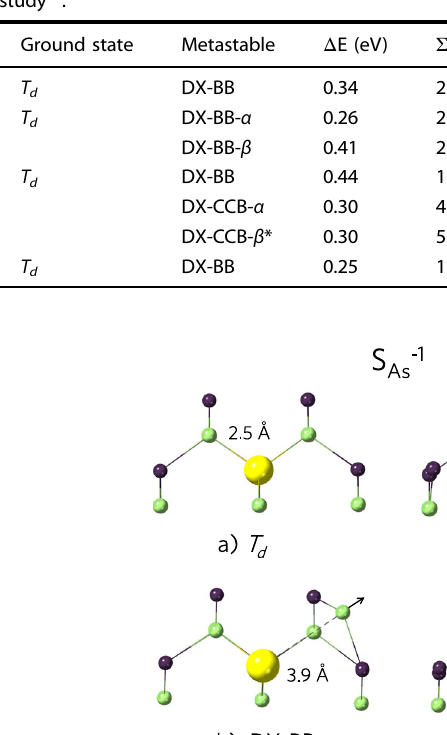
, we include a As